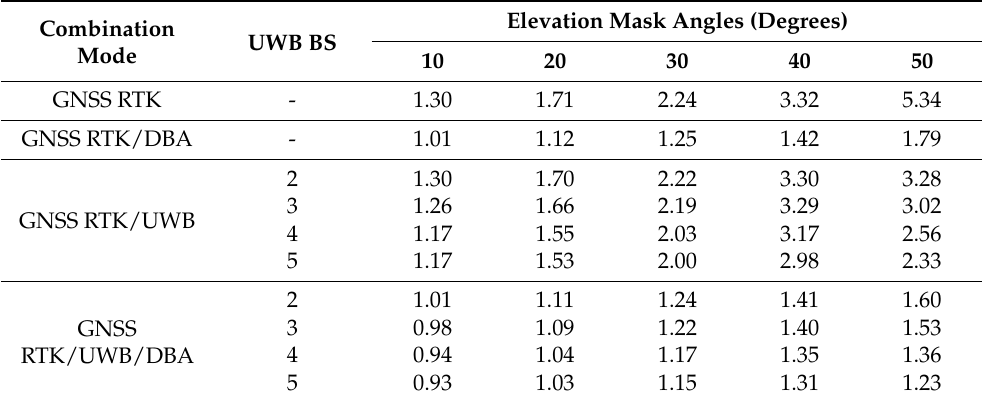
Table 6. Average PDOP values of the GNSS RTK/UWB/DBA fusion positioning model at various elevation mask angles in the dynamic cart